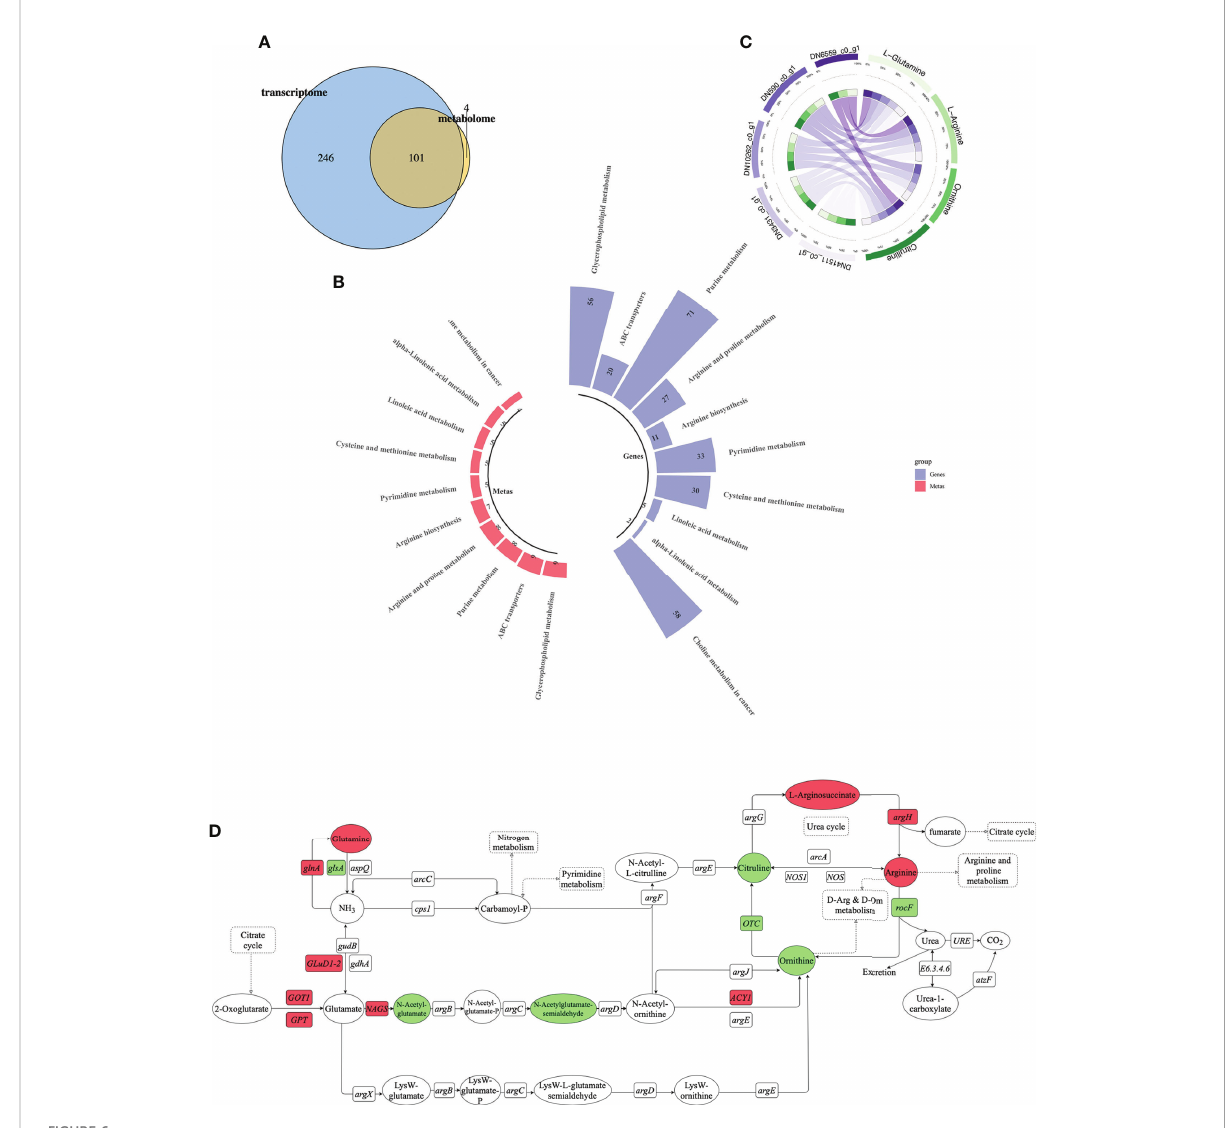
FIGURE 6 Combined transcriptomic and metabolomic analysis. (A) Venn diagram of DEM-enriched pathways and differential metabolite-enriched pathways (blue is transcriptome, yellow is metabolome, and round cross region represents number of shared KEGG pathways). (B) Top 10 pathways containing most DEGs and differentially expressed metabolites. Each column represents a KEGG pathway. Blue represents transcriptome, red represents metabolome. (C) Correlation analysis between differentially expressed metabolites and DEGs. Purple represents DEGs, green represents differentially expressed metabolites. (D) Schematic of arginine biosynthesis pathway. Green indicates down-regulation, red indicates up-regulation. Circle represents metabolites, rectangle represents